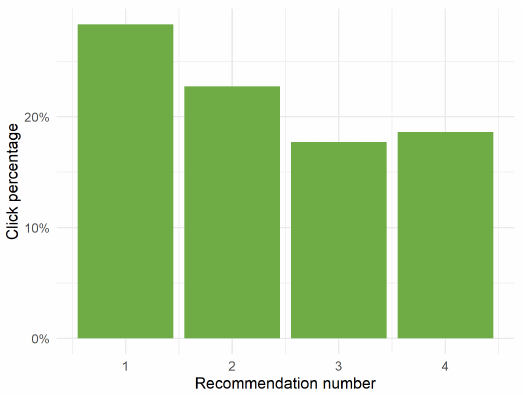
Figure 12. Percentage of clicks in recommendations per list